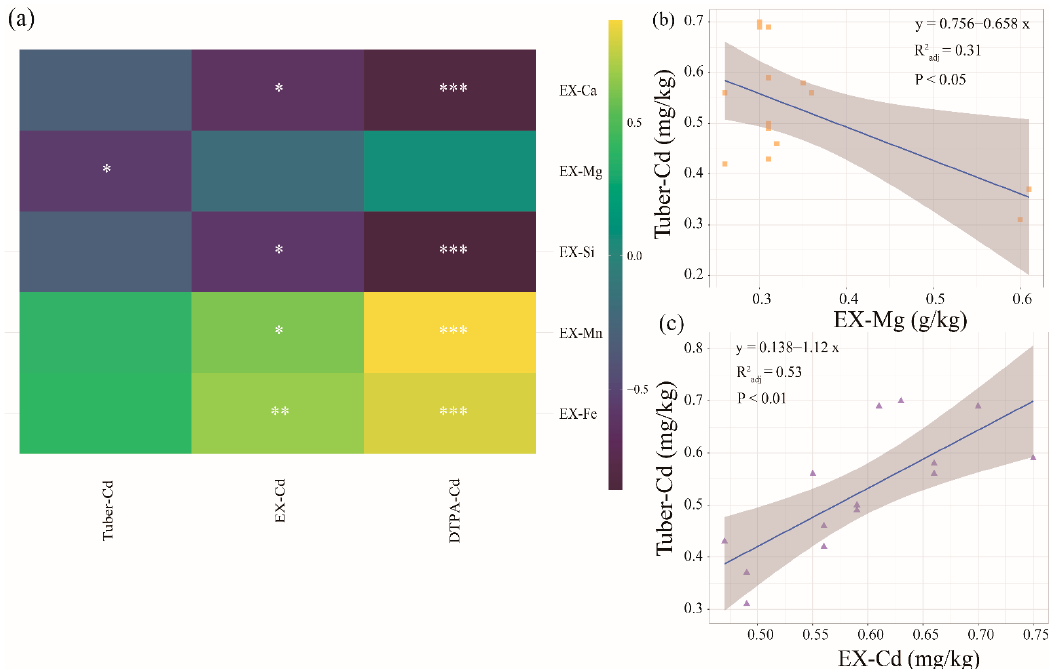
Figure 5. The correlation between the passivation effects and the soil cations. ( a ) The heatmap represents the correlation of parameters (Spearman correlation coefficient). The color difference represents the correlation coefficient and the asterisk indicates that the correlation is significant, “*” ( p < 0.05), “**” ( p < 0.01), “***” ( p < 0.001); ( b ) The linear regression of EX-Mg versus Tuber-Cd. ( c ) The linear regression of EX-Cd versus